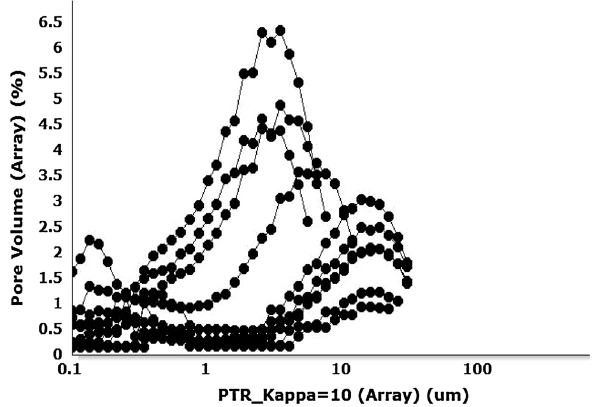
Fig. 4 Pore throat size distribution derived from NMR capillary pres- sure for kappa = 10 (after Olubunmi and Chike)